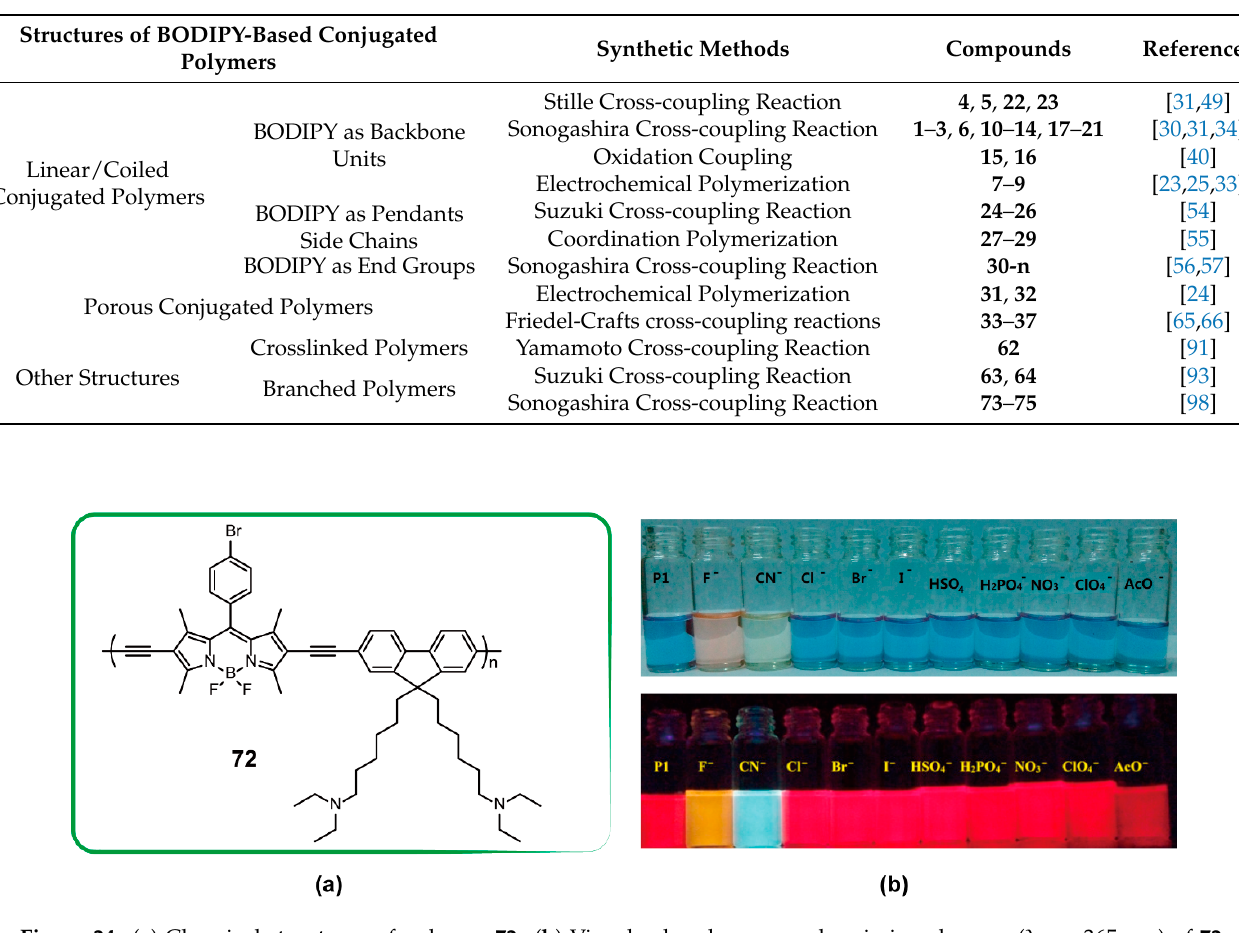
Figure 25. Chemical structures of polymers 73–75 [98] (Reproduced with permission from Reference [96]. Copyright @ 2016, Royal Society of Chemistry). 3.4. Gas/Energy Storage Generally, conjugated porous polymers (CPPs), owing to their favorable structures, have been extensively applied to gas or energy storage, and BODIPY units are rich in het- eroatoms, amplifying their affinity to gas or other substances [100–103]. Patra and cowork- ers [103] prepared four BODIPY-based CPPs 76 – 78 (Figure 26) with various alkyl chain lengths at meso-positions via Sonogashira cross-coupling reaction. Polymer 76 possessed